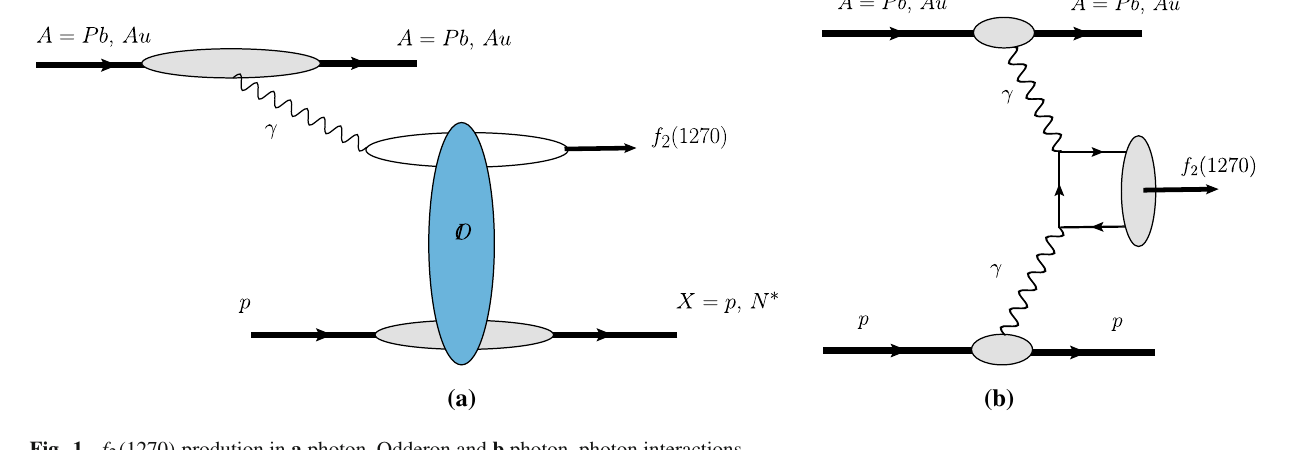
Fig. 1 f 2 ( 1270 ) prodution in a photon–Odderon and b photon–photon interactions